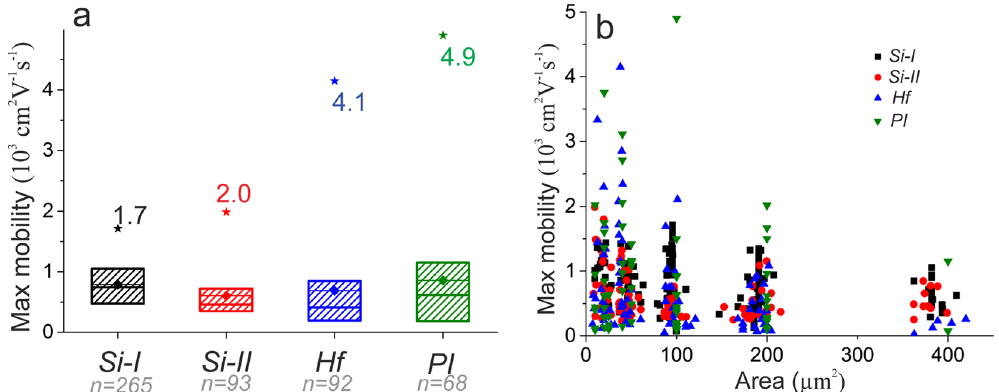
Figure 5. ( a ) The statistical distribution of the mobility values and their max values of the four wafers; black: Si-I, red: Si-II, blue: Hf, green: PI.. The box is 25% to 75%, the line with diamond shows mean value and the solid line the 50% value. ( b ) The scatter plot of all mobility values over the tested areas of graphene. One can see a general area-irrelevance, except for the smallest